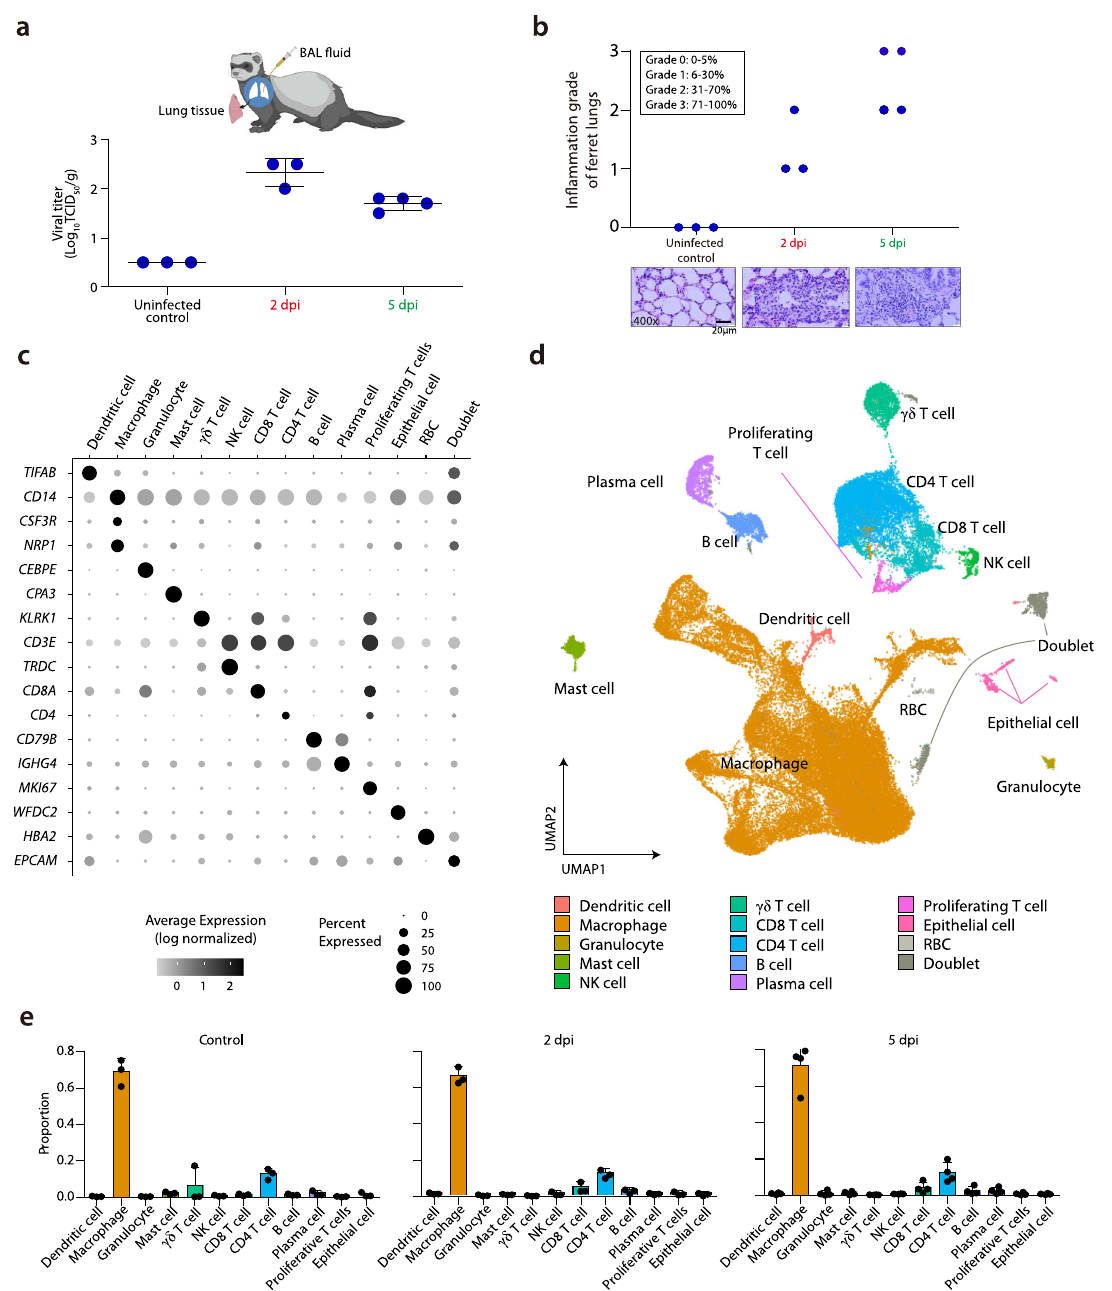
Fig. 1 Single-cell transcriptomes of BAL fl uid cells from SARS-CoV-2-infected ferrets. a Summary of experimental conditions with viral titers in the negative control, at 2 days post-infection (dpi) and 5 dpi. b Histopathologic scoring of the lung tissues of negative control ferrets, and SARS-CoV-2-infected ferrets on 2 and 5 dpi. The scale bar indicates 20 μ m. c Fourteen different clusters and their speci fi c marker gene expression levels, where brightness indicates log-normalized average expression, and circle size indicates percent expressed. d UMAP of 59,138 cells from the bronchoalveolar lavage (BAL) fl uid of 10 ferrets, colored to show annotated cell types. e The proportion of each cell type at uninfected control ( n = 3), 2 dpi ( n = 3), and 5 dpi ( n = 4). NK natural killer, RBC red blood cell, TCID 50 median tissue culture infectious dose. The height of bars indicates mean and error bars indicate standard deviation. Source data are provided as a Source Data fi